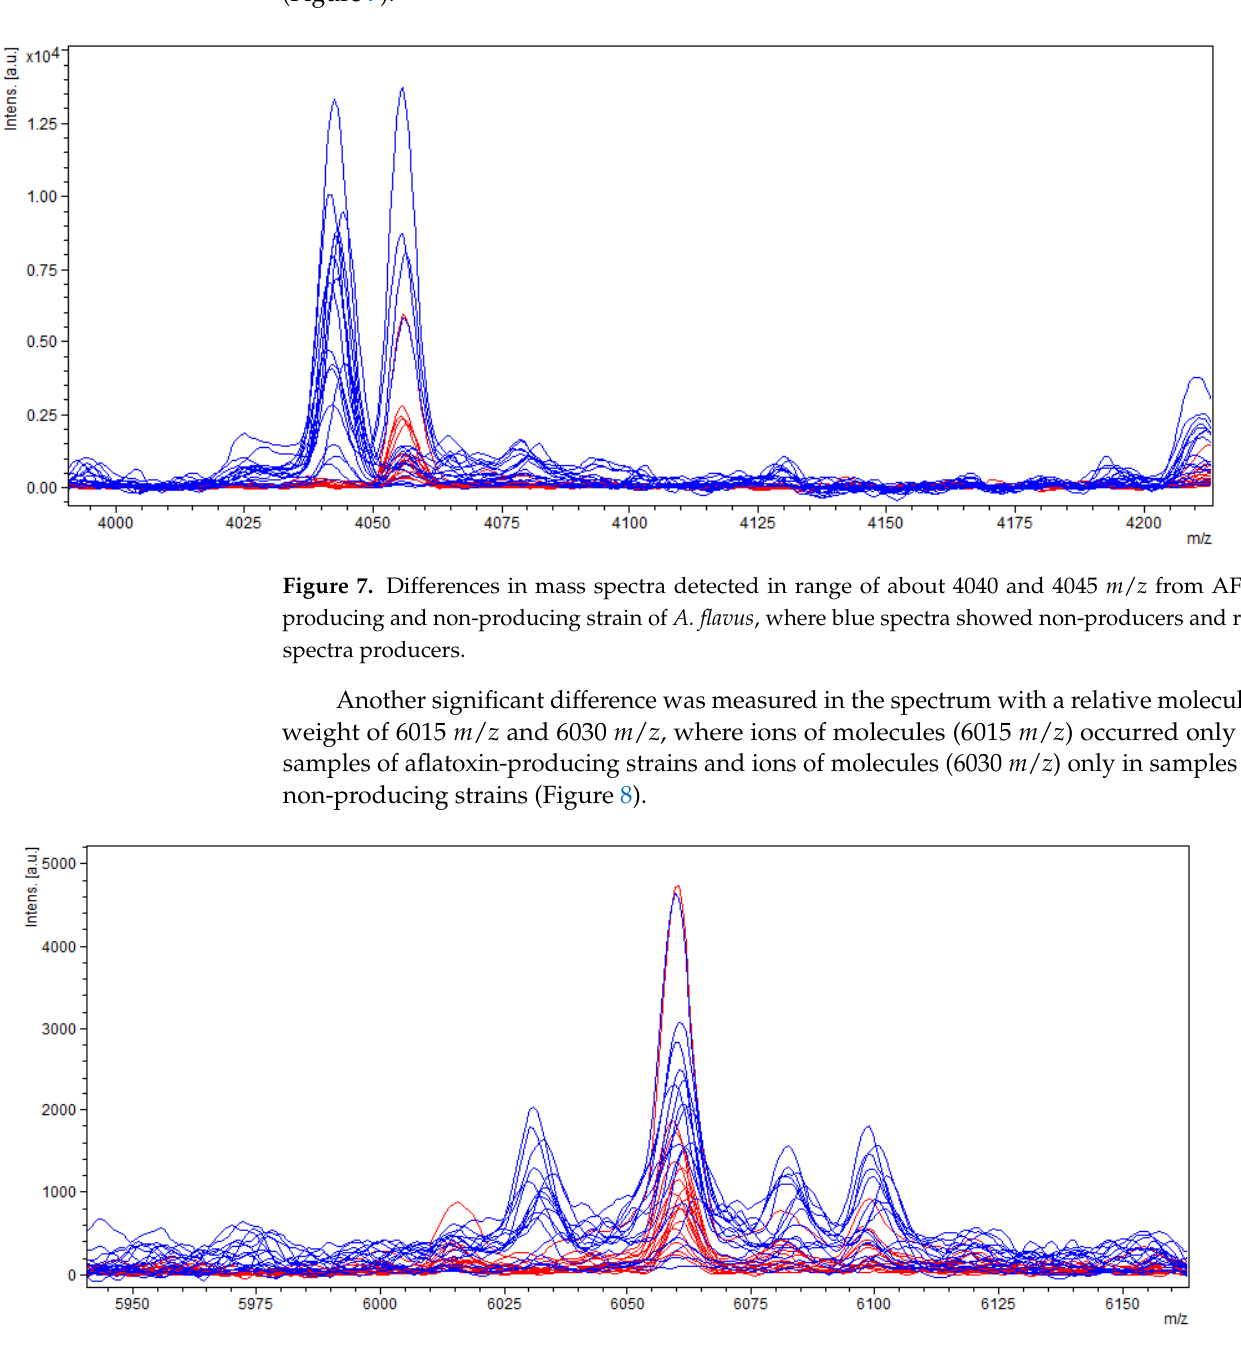
Figure 8. Differences in mass spectra detected in range of about 6015 and 6030 m/z from AFB 1 pro- ducing and non-producing strain of A. flavus , where blue spectra showed non-producers and red spectra producers.